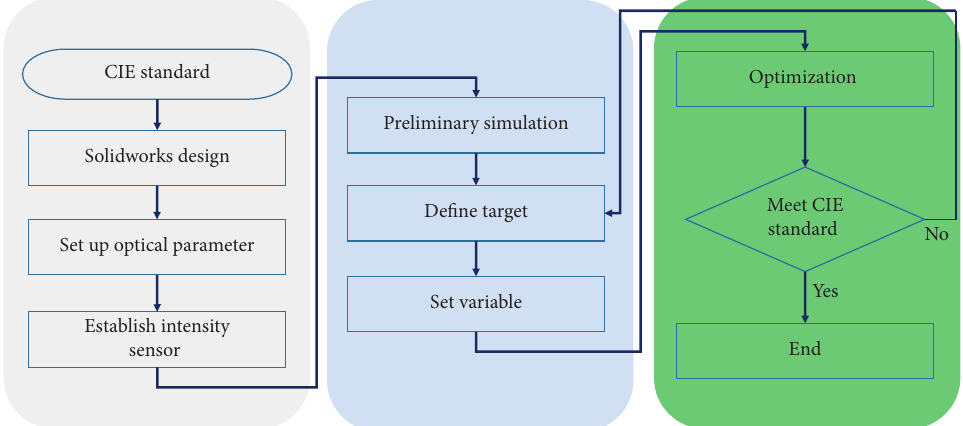
Figure 9: Flowchart of the optimization process for the proposed luminaire.